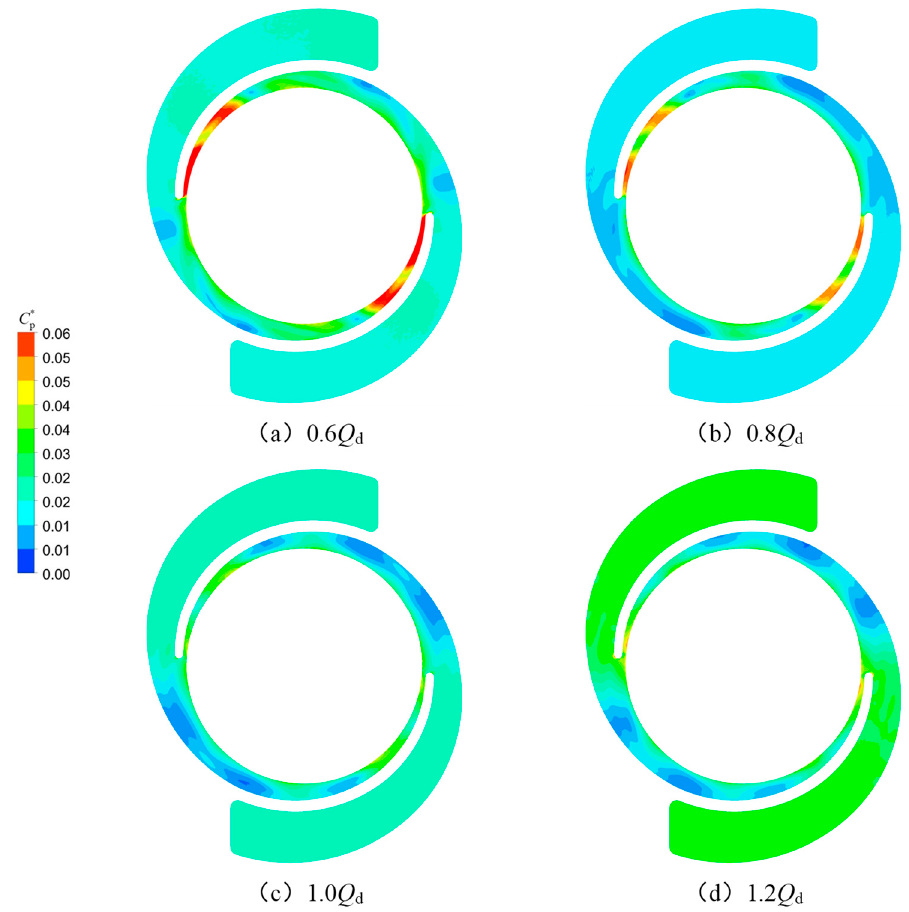
Figure 10. Pressure fluctuation intensity distribution on the mid-span of the forward channel under di ff erent fl ow rates.